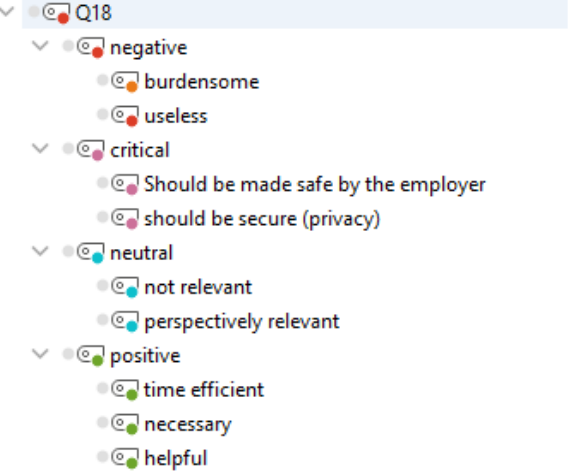
Figure 6. System of assigned codes and sub codes to the question “How do you evaluate the use of communication apps in everyday hospital life? ” (Q18, N = 49/70).